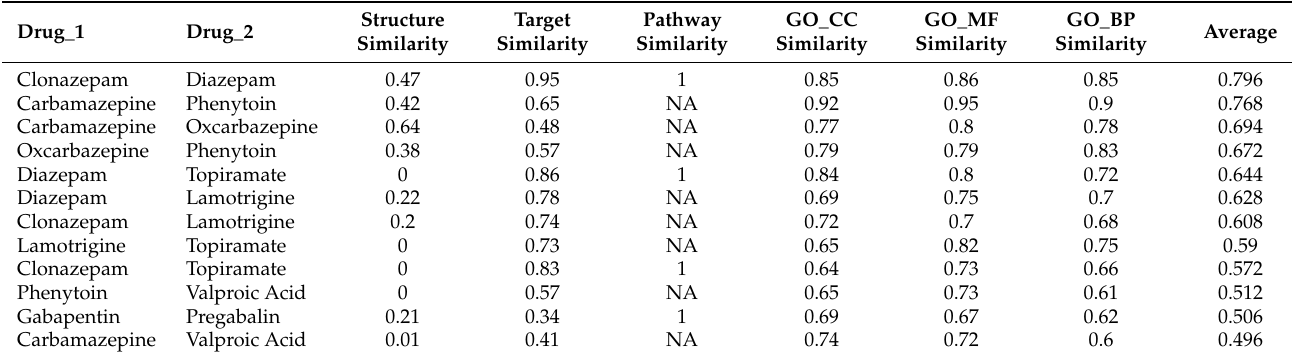
Table 13. Agreement Analysis of Similarity Measures Performance.